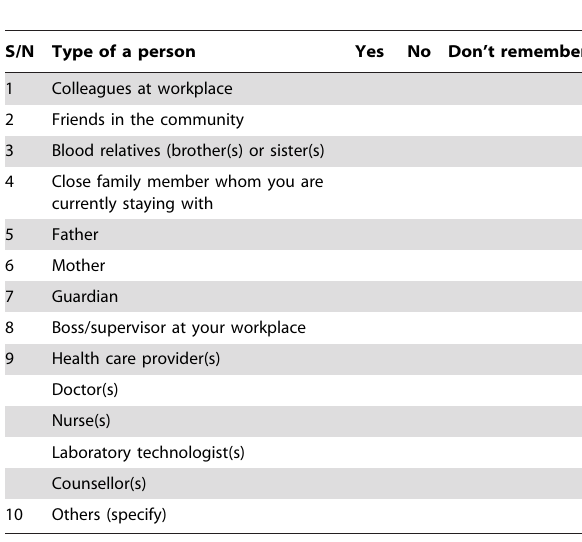
Table 1. Negative comments/reactions from various people (Insert tick [ ! ] in the appropriate box(s)).